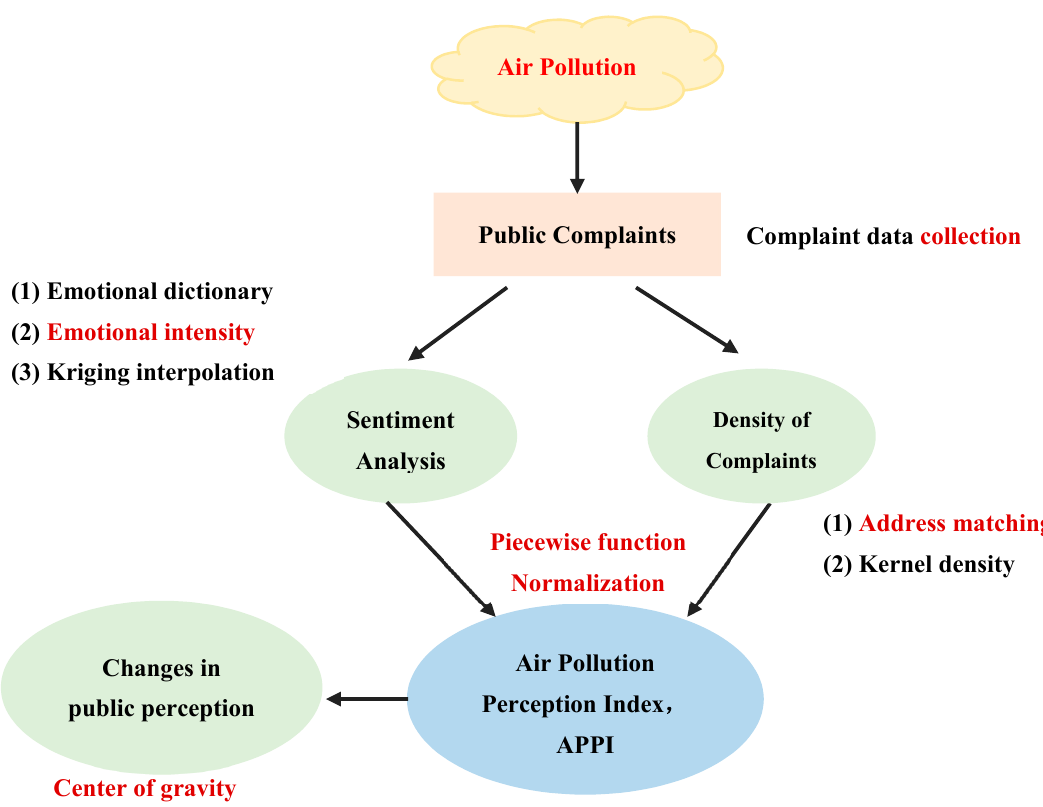
Figure 1. Flow chart of air pollution perception index (APPI) based on public complaint data and emotional analysis .